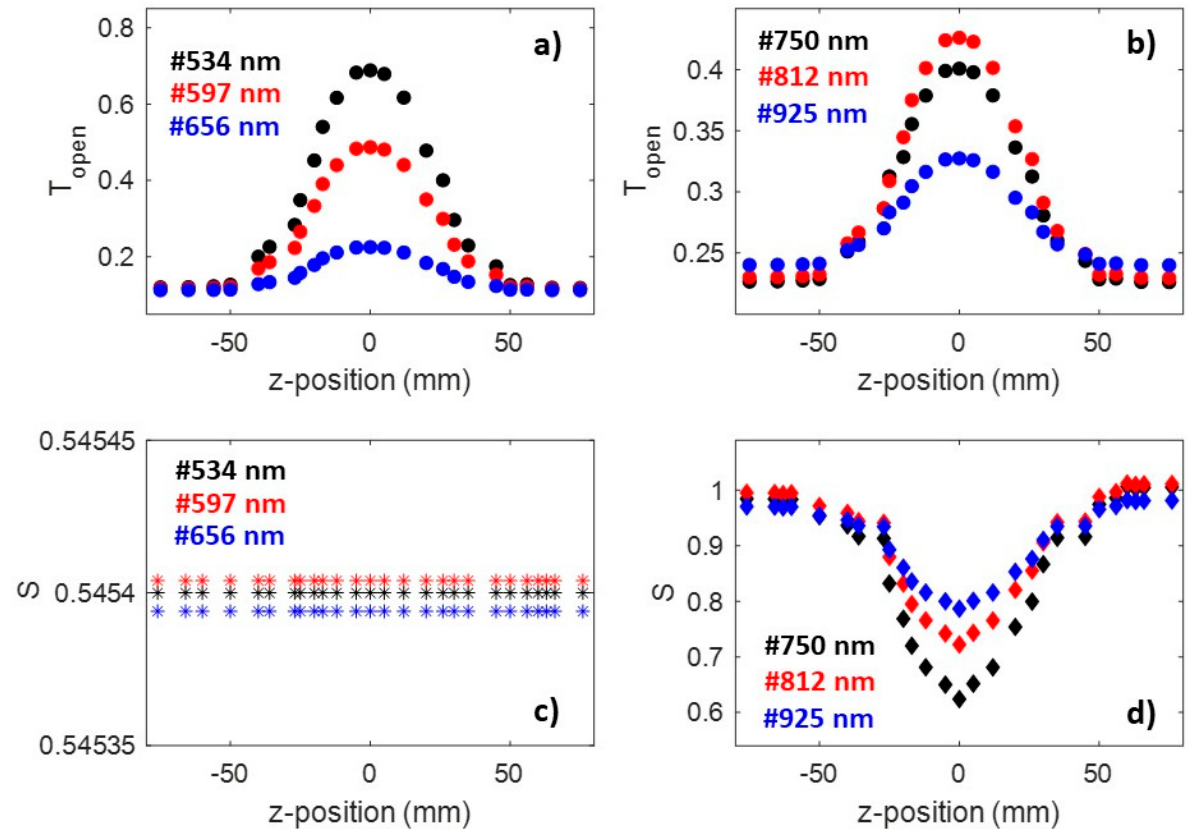
Figure 5. z-scan profiles in open ( a , b ) and scattering ( c , d ) configurations for the samples #534, #597, and #656 nm as well as for the samples #750, #812, and #925 nm.